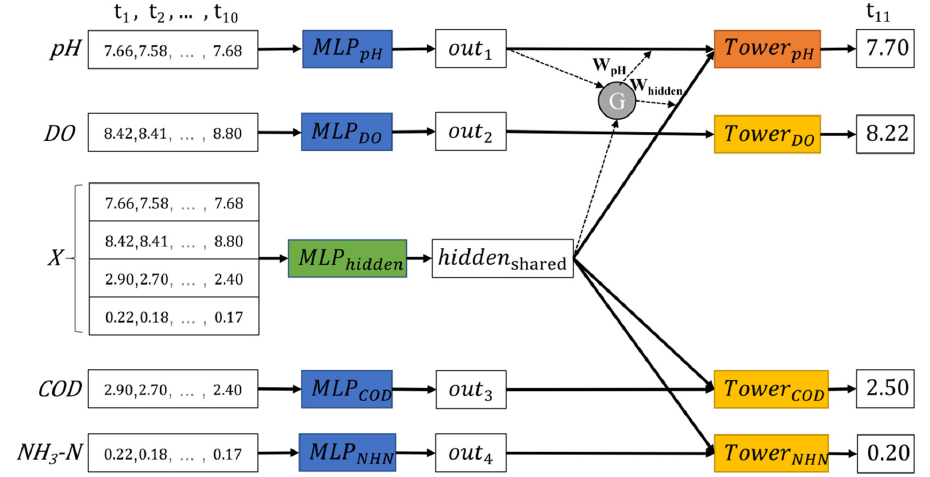
Figure 6. An example of the kind of time series for each indicator. Algorithm 4: Gated Hidden Parameter Sharing Structure Multi-Task Learning for Multi- indicator Water Quality Prediction